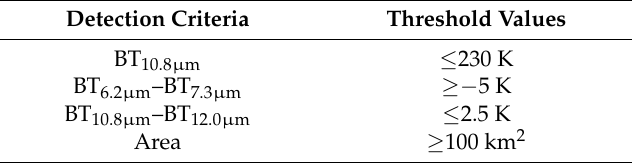
Table 1. Criteria used to detect convective cloud cells (cloud tops) in the Meteosat